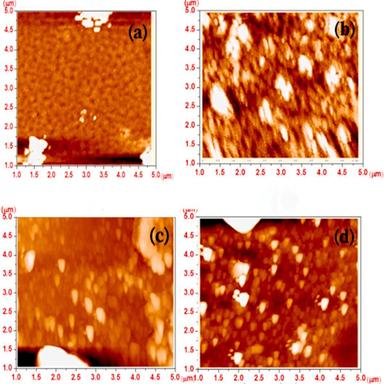
AFM micrographs of (a) pure, (b) 1.0%, (c) 2.5% and (d) 7.5% La doped NiO thin films.